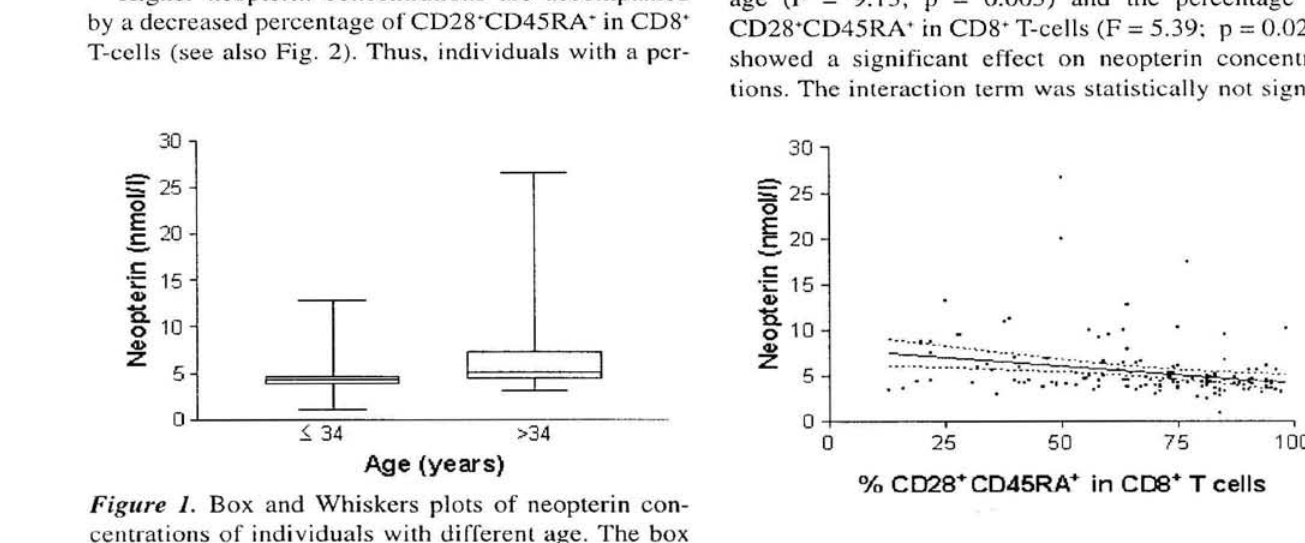
Figure 2. Scatter plot of the percentage of CD28" CD45RA* in CD8* T cells versus serum neopterin con- centrations in healthy individuals. Straight line indi- cates linear regression (neopterin concentration = 8.098 - 0.039 X %CD28" CD45RA* in CD8* T cells; n = 138; R = 0.259; p < O.Ol) and dotted curves its 95% confidence